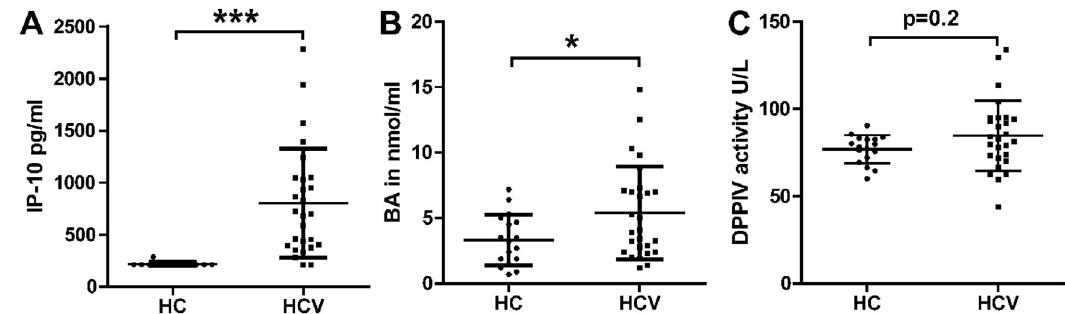
Fig 3. Serum IP-10, BA and DPPIV activity in a prospective FU cohort. 27 HCV patients IP-10 levels as well as BA levels were significantly higher compared to HC. DPPIV serum activity was higher in HCV patients, but without reaching